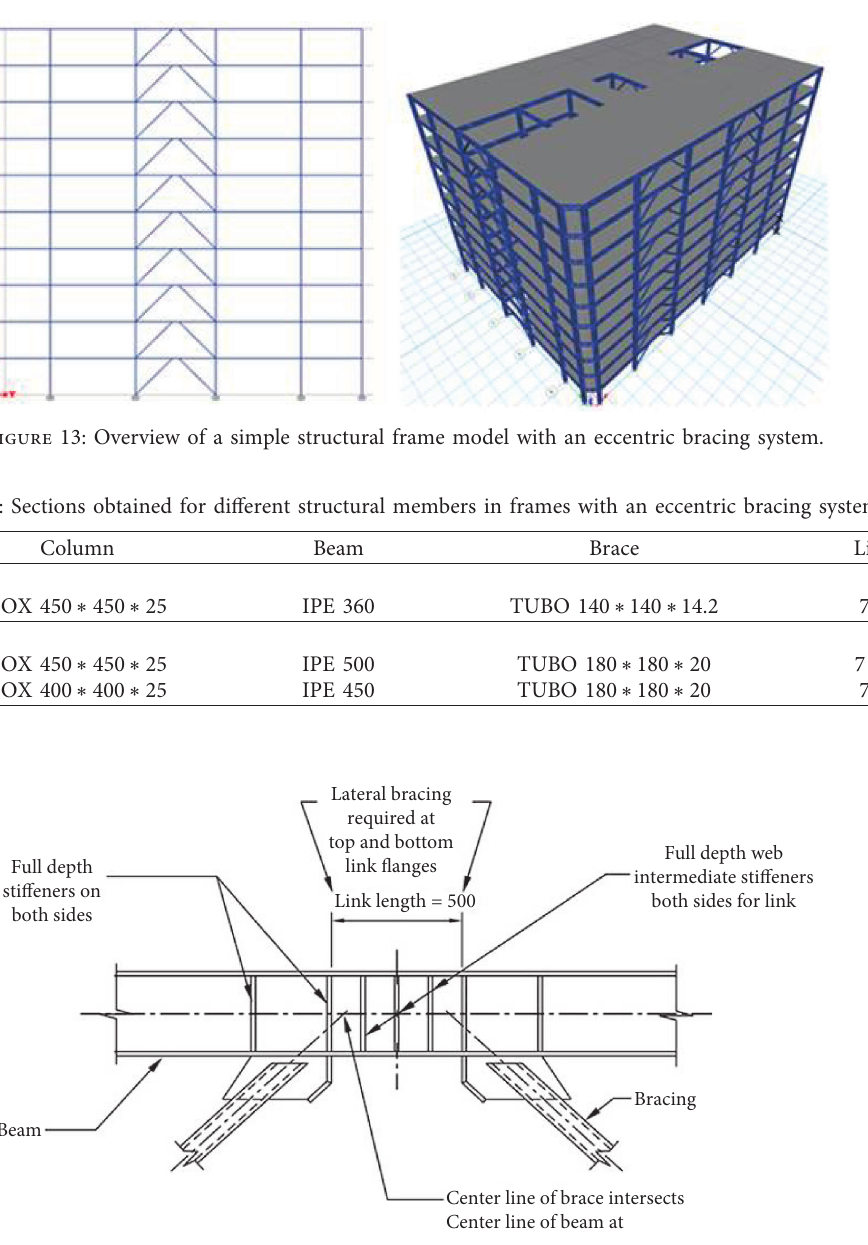
Figure 14: A schematic example of the execution detail used for one of the link beams.